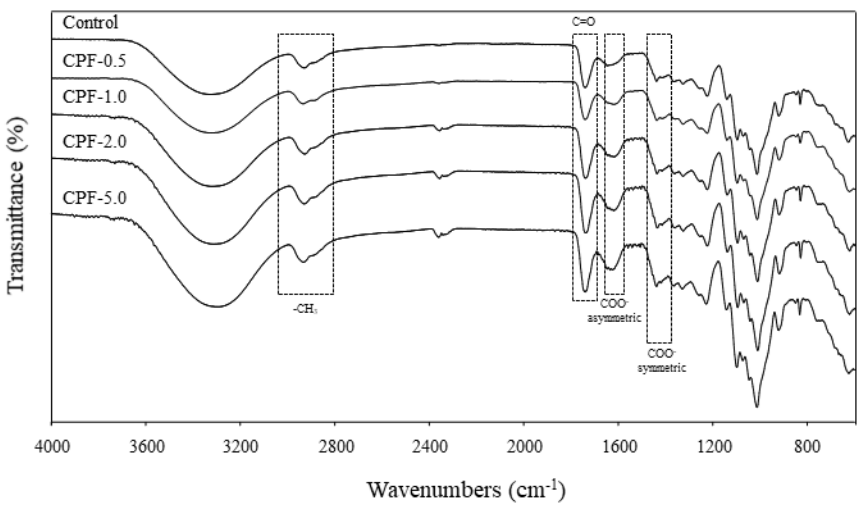
Figure 1. FTIR spectra of pure pectin film (control) and crosslinked pectin films (CPF) with 0.5, 1, 2, and 5% CaCl 2 .